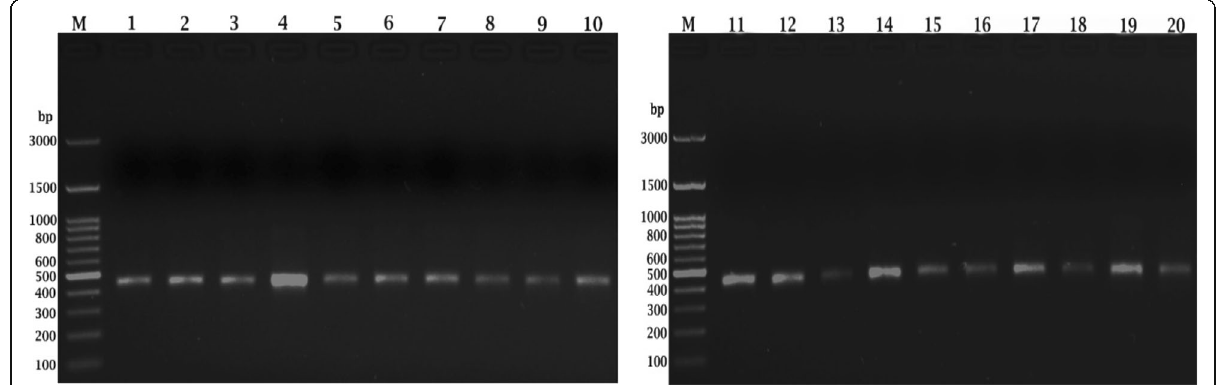
Fig. 1 PCR amplified matK fragments from 20 different Triticum